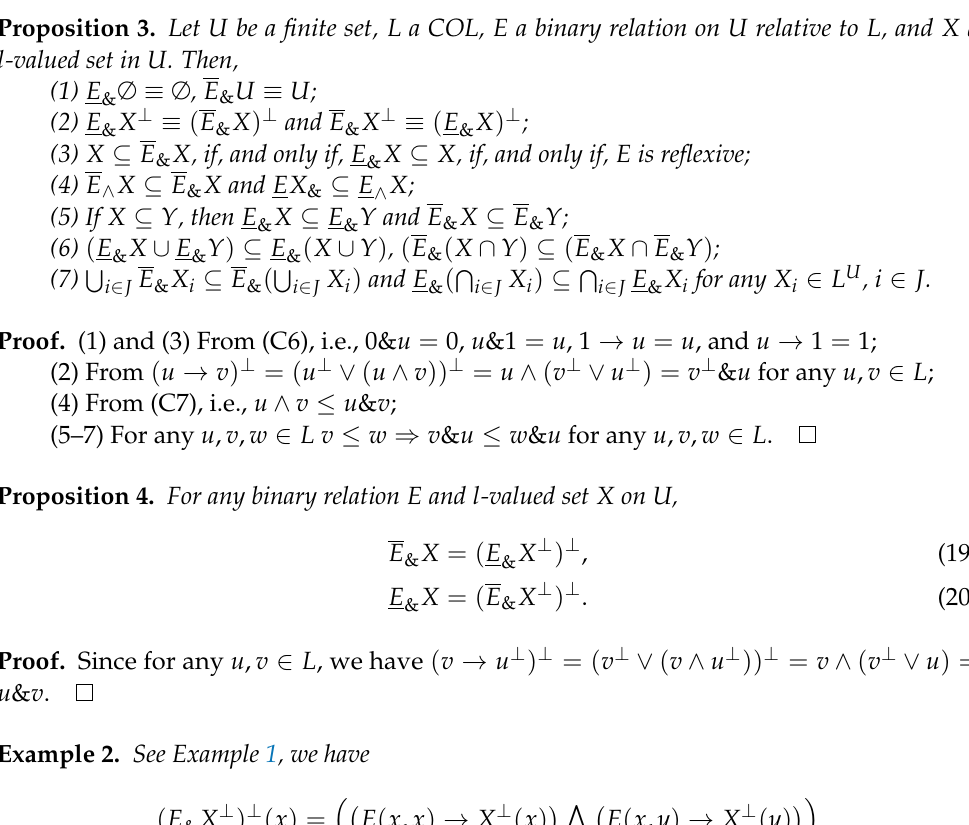
Figure 1. Orthomodular lattice MO2